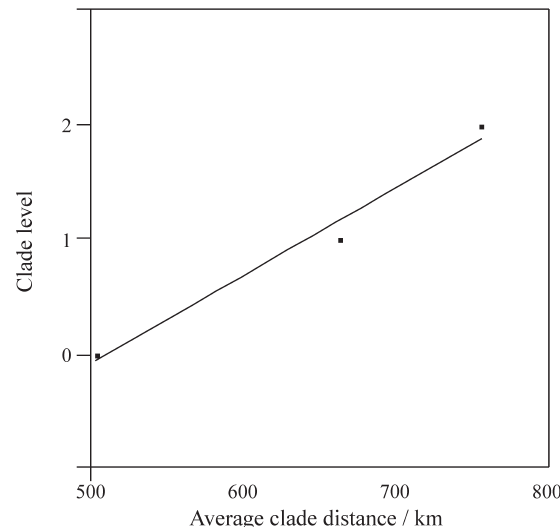
Figure 3 - Average nested clade distance (D n ) in Clade 2-2. Nested clade indicates average D n for 0-step and 1-step clades nested in Clade 2-2 and D n of Clade